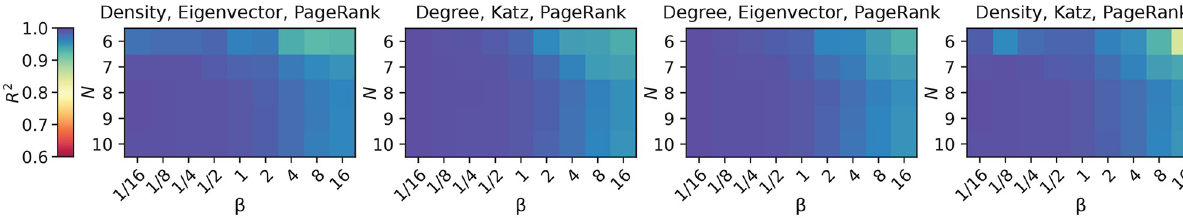
Fig 11. The most predictive triplets of node centralities (including the number of edges). The coefficient of determination R 2 when O ( β ) is estimated over graphs of N nodes. The centrality triplets appear in decreasing order of the largest minimum R 2 across β values at N = 10: these four combinations reach R 2 values between 0.96 and 0.95 (and many other triplets, not shown here, also score above R 2 = 0.90).